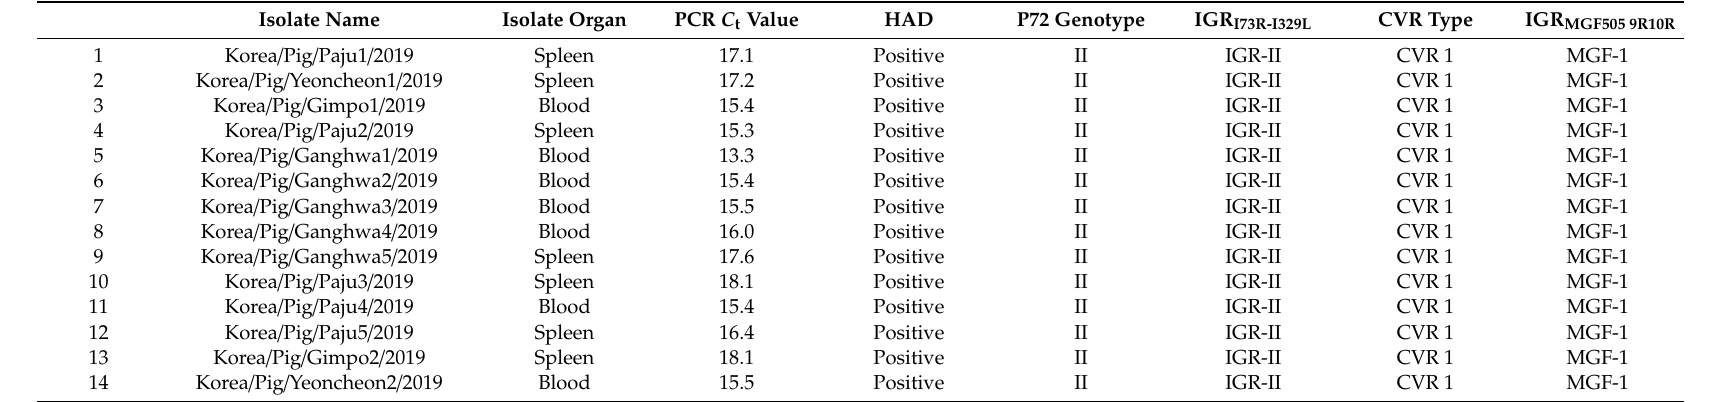
Table 1. Summary of the isolation and genetic characterization results from ASFV isolates 2019 in South